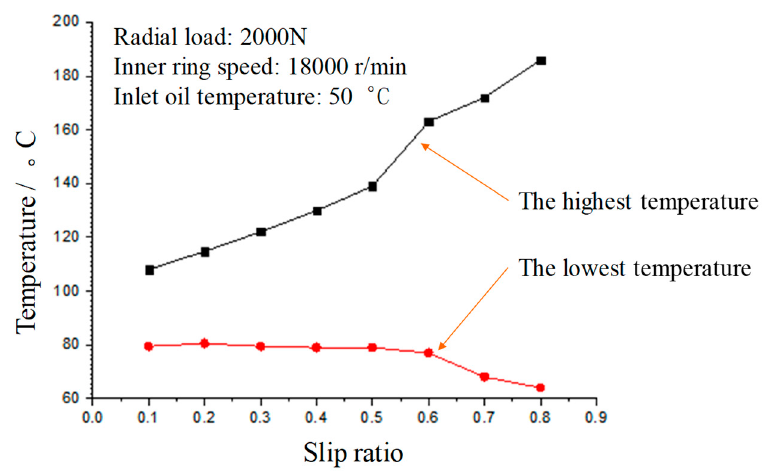
Figure 10. Effect of the slip ratio on the bearing temperature distribution.